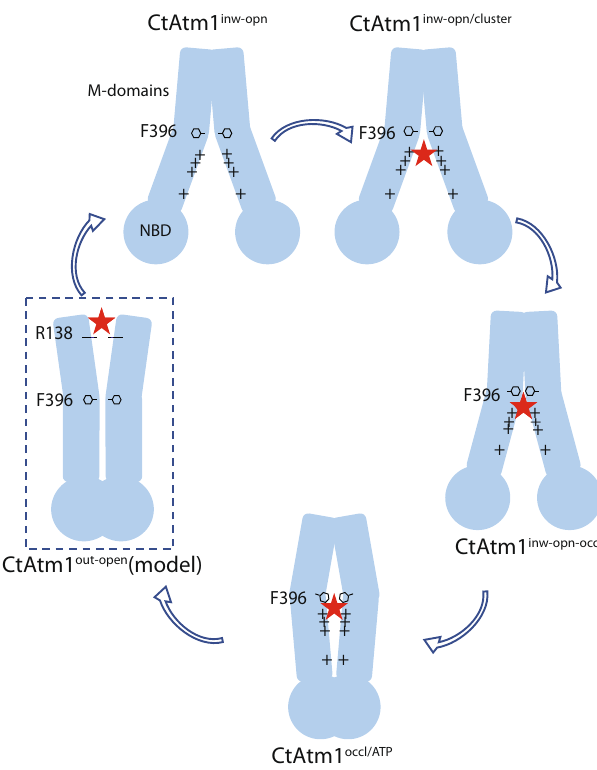
Fig. 5 | Mechanism of cluster transport by Atm1. We propose the inward-open con fi gurationrepresentstherestingstateofeukaryoticAtm1proteins,inwhichthe protein exposes a highly electropositive cleft to the inside of the mitochondrial matrix, as detected in the CtAtm1inw-opn (and E603QCtAtm1inw-opn) structure. Thisstatepermitsnegativelychargedglutathione-bound[2Fe-2S]clusters(redstar) to associate in the vicinity of the cleft, as observed in our CtAtm1inw-open/cluster structure. Cargo and likely nucleotide binding to the positively charged cavity in the transmembrane domain and the nucleotide-binding domain, respectively, triggerconformationalchangesthatresultinreorganizationoftheF396innergate, partial occlusion (as in the CtAtm1inw-opn-occl structure) and then complete occlusion (as in the CtAtm1occl/ATP structure), with local chemistry of the cargo- bindingpocketthatisdistincttoprokaryoticAtm1proteins.Weanticipatethe[2Fe- 2S]clusteror(an)intermediate(s)thereofisenclosedintheoccludedstate.Release to the intracellular side is likely coupled to further conformational adaptation, straightening of TM6 to permit passage across the inner gate, and opening the transport pathway. Once the cargo is liberated from the protein, ATP hydrolysis takes place, permitting a new transport